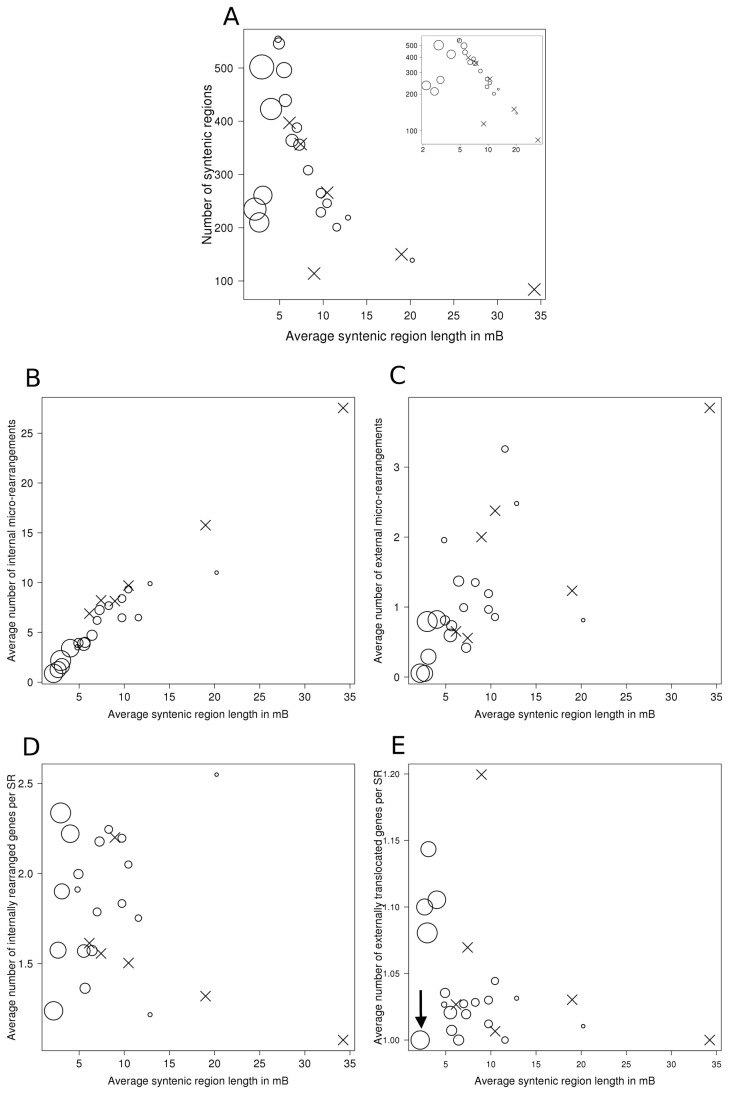
Relationship of syntenic region length, evolutionary distance and other features.Dependence of synteny features on the average syntenic region length (x axis) and evolutionary distance (circle size, inferred from branch lengths in Miller et al (2007), calculated as the average number of substitutions per site). Crosses correspond to the species pairs with no distance information available. A) Negative exponential correlation between the number of syntenic regions and their average length (inset: logarithmic axis scales). Closely related species (small circles) tend to have fewer, longer syntenic regions. Distant species (large circles) tend to have high numbers of very short syntenic regions. B) The average number of internal micro-rearrangements per syntenic region strongly correlates with syntenic region length and evolutionary distance. Evolutionary distant pairs of species share short syntenic regions with few internal micro-rearrangements. C) No clear correlation between syntenic region length and rearrangement number can be observed for external micro-rearrangements. D) The size of internal micro-rearrangements (average number of genes involved) does not correlate with the syntenic region length and evolutionary distance. E) Similarly, the number of genes involved in external translocations is generally independent of the syntenic region length. However, with the exception of mouse and platypus (average number of genes in externally translocated regions: 1.0, marked by arrow), distant species pairs tend to have somewhat longer externally translocated regions (average>1.05).